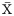
Area of the of the study, Northwestern Ethiopia: A district in the rural area of Bahir Dar city, the capital of the Amhara Regional State, in the south shore of Lake Tana.The five villages included in the study are showed. Data about the studied population, age and gender are noted. n = number of population recruited in the village Y = Range of age; X¯ = mean of age; F = female (%) (Map: Sentinel-2 (ESA) image courtesy of the U.S. Geological Survey).